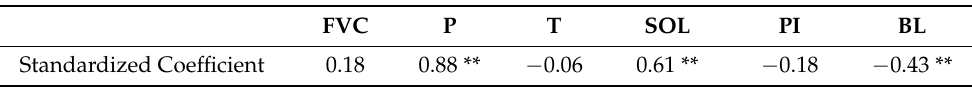
Table 9. The linear regression correlation coefficient of soil conservation services in the Loess Plateau Ecological Screen.